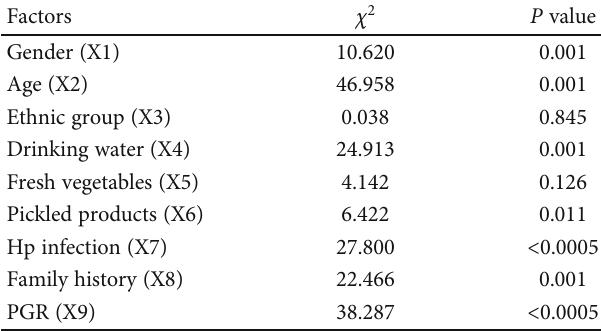
Table 1: Mono factor analysis results of in fl uencing